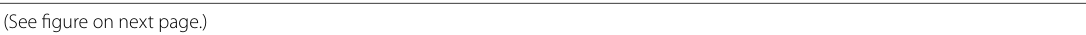
figure on next Fig. 4. 13 C‑labelled glucose metabolic flux and intracellular long‑chain unsaturated fatty acids metabolism differences and Bioenergetics by Seahorse XFp metabolic flux analysis. A Tyrosine, phenylalanine, and tryptophan owned a lower rate of biochemical conversion after FoxO3a depletion. B Our intracellular metabolic result showed differences in long‑chain unsaturated fatty acids between sh‑NC and knockdown groups, and differential metabolites mostly belong to omega‑6 or omega‑3 fatty acids. Omega‑3 and omega‑6 fatty acids are mainly involved in inflammation and migration progress. Results are shown as mean SEM, n 3, * P < 0.05, ** P < 0.01 and *** P < ± =